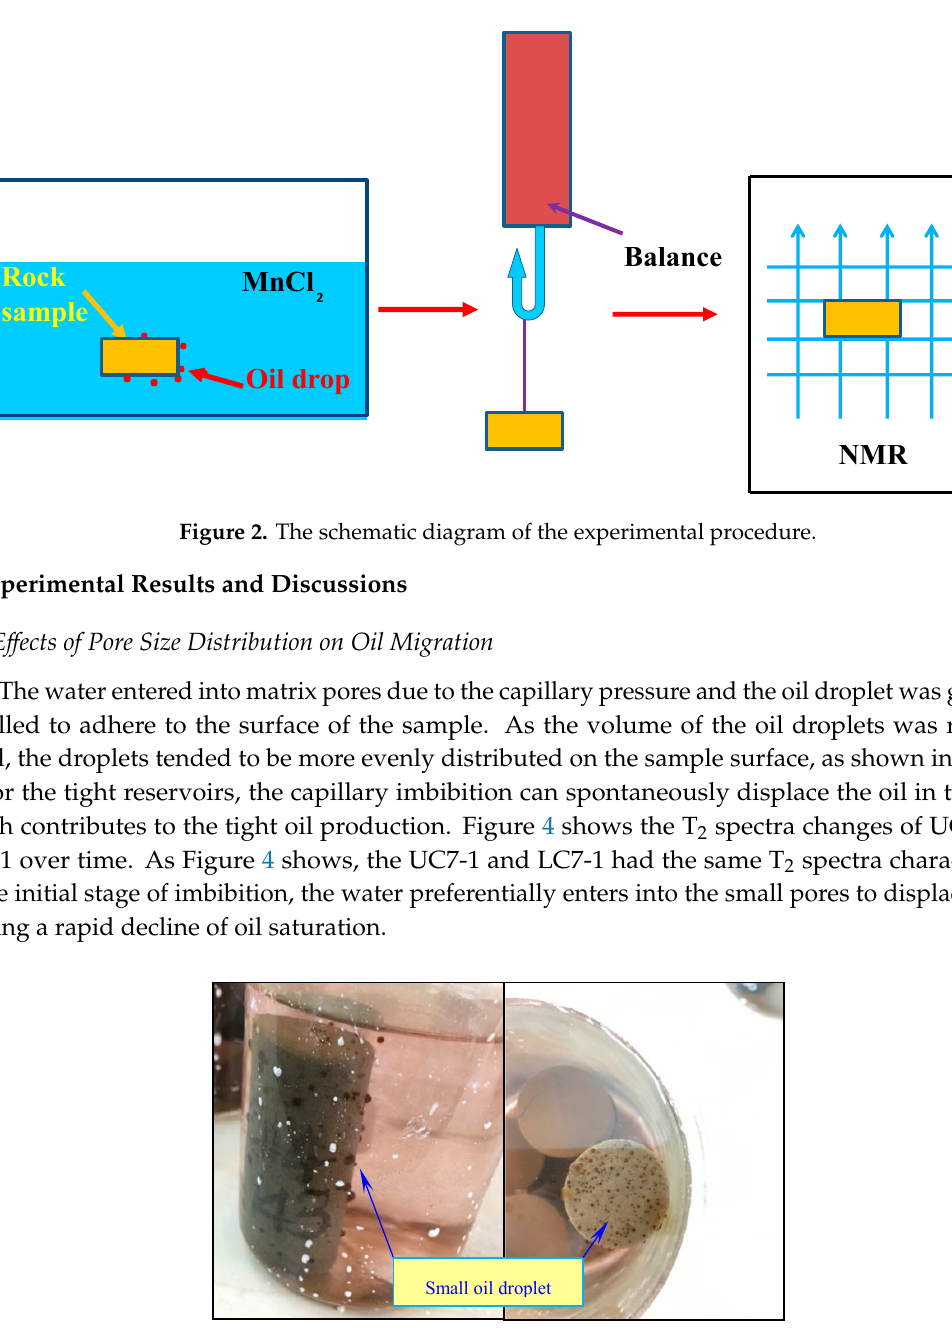
( b ) Figure 4. The T 2 spectra vs soaking time in UC7-1 and LC7-1 samples: ( a ) UC7-1 and ( b ) LC7-1. 00.10.20.30.40.5 0.6 0.70.8 0 ( b ) Figure 5. Oil recovery in different diameter pores: ( a ) UC7-1 and ( b ) LC7-1. According to the T 2 relaxation time of Meng et al. (2016) [19], the tight rock pores were divided into micro-pores (<1 ms), small pores (1–10 ms), largish pores (10–100 ms) and large pores (>100 ms). The largish pores and large pores included micro-fractures and matrix pores. Figure 5 presents oil recovery in different diameter pores. The oil recovery of the micro-pores was larger than 70%, that of small pores and largish pores was much lower than 30% and that of largish pores was about 40%. Unexpectedly, the smaller pores did not have a much larger imbibition oil recovery. In Figure 5a, the oil in micro-pores began to decrease at 0 h, but the oil in large pores began to decrease at 100 h. The water preferentially enters the micro-pores under the capillary pressure and the oil drop displaced by water enters the large pores. Figure 6 presents the schematic diagram of oil -0.100.10.20.30.40.50.60.7 0